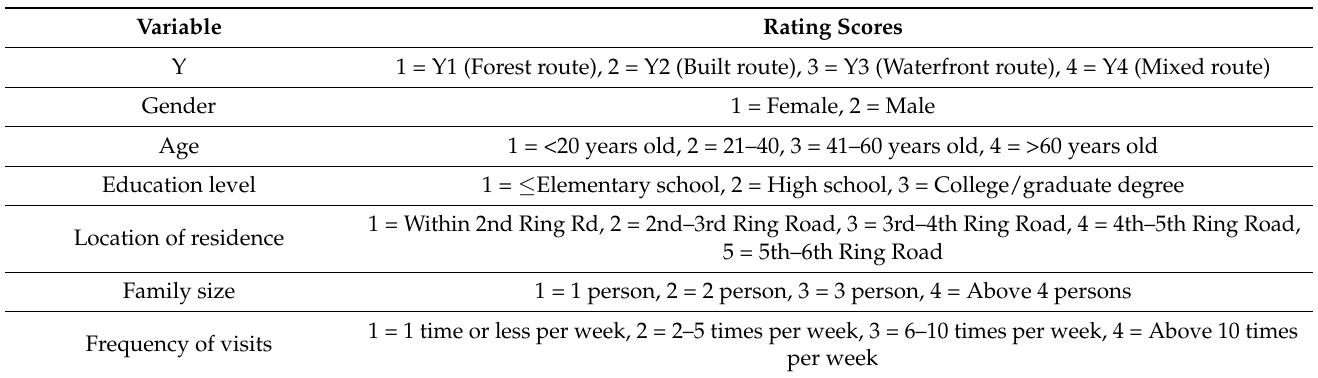
Table 1. Variables and rating scores of this